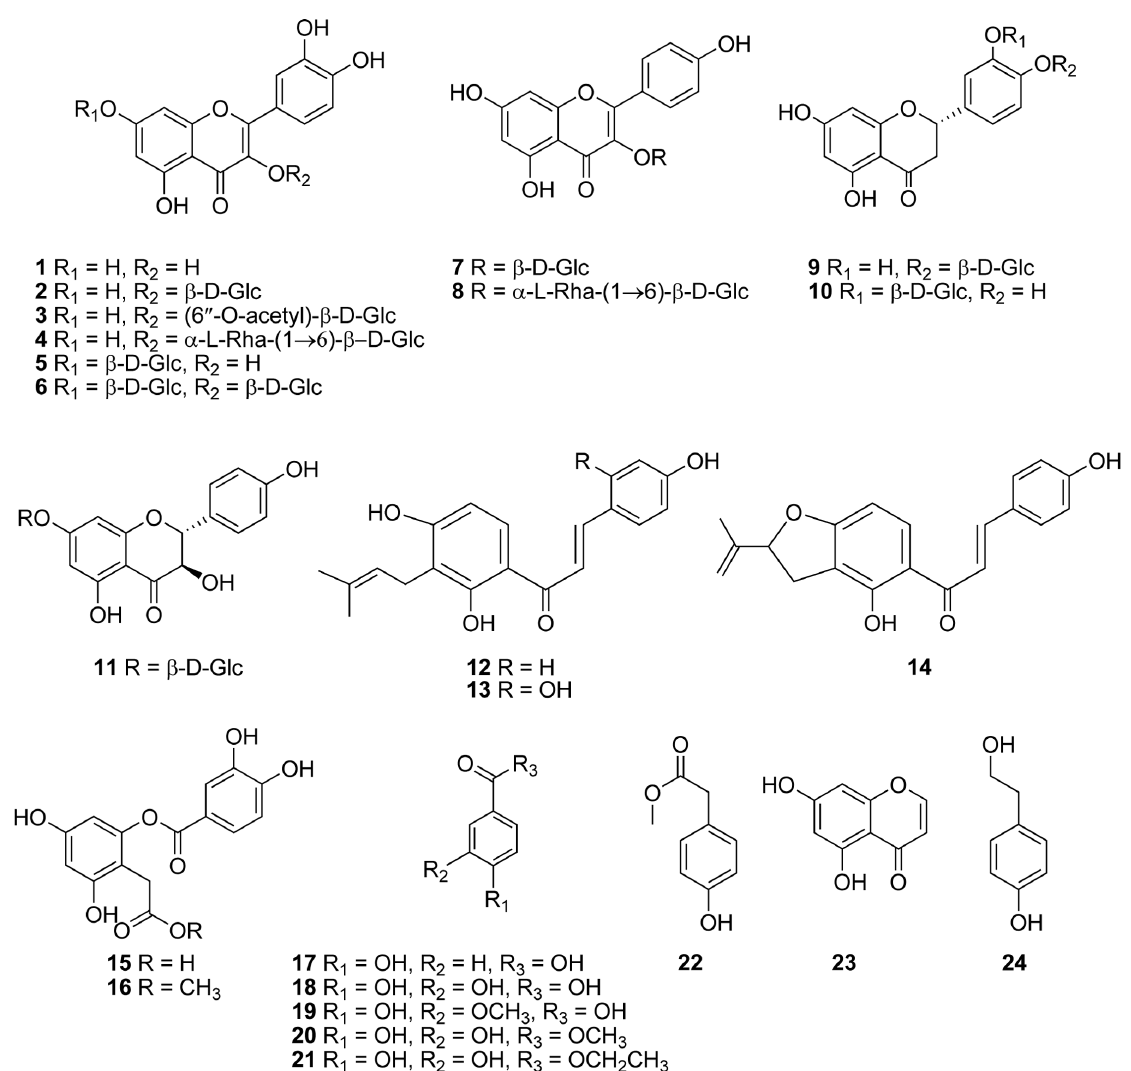
Figure 1. Chemical structure of compounds 1 2 24 isolated from mulberry fruit ( Morusalba L.)